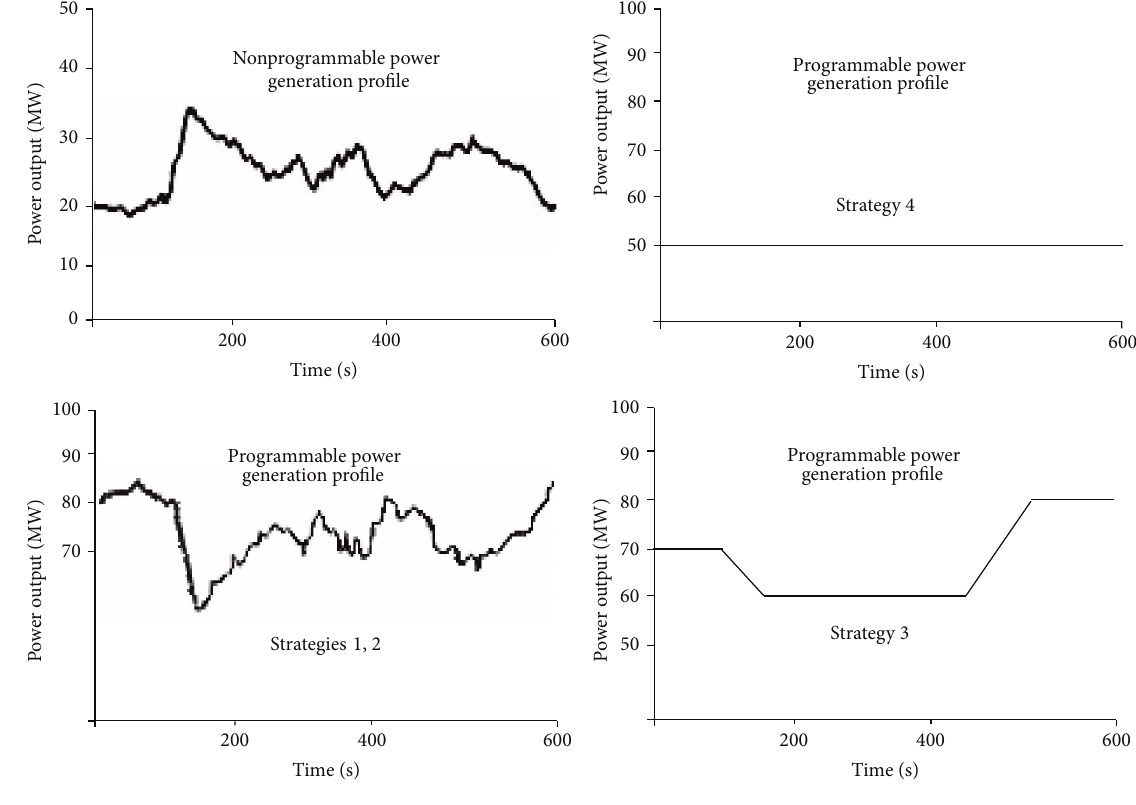
Figure 2: Productive